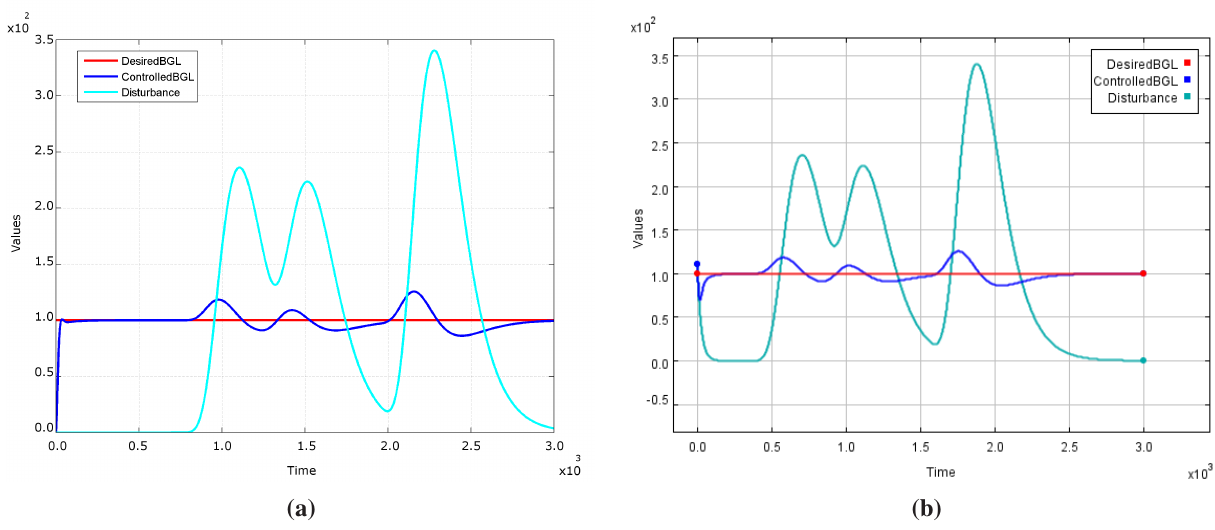
Figure 7. Comparative Result Between BGL Control System’s Original Model at Simulink and Replicated Model at Ptolemy II After Simulation of 3000 Time Units. ( a ) Simulink; ( b ) Ptolemy